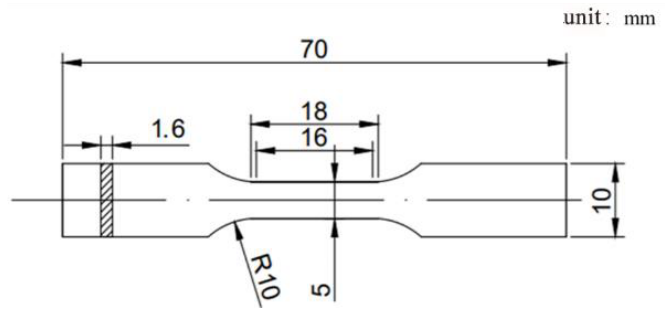
Figure 2. Schematic of the tensile test specimen.